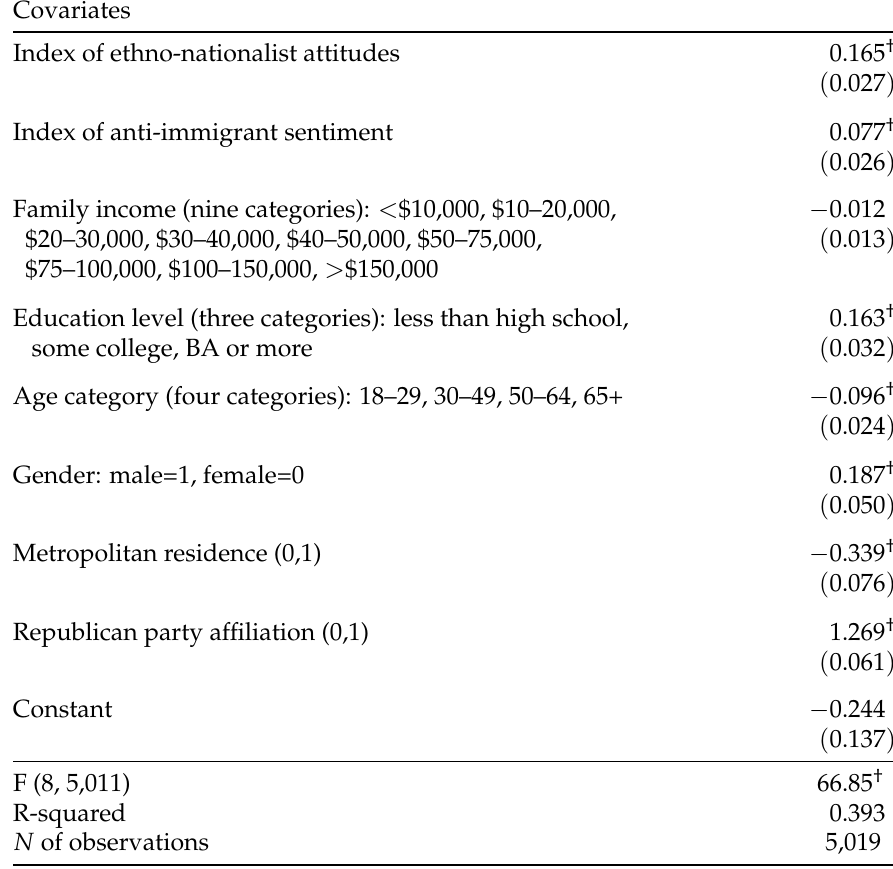
Table 2: Regression estimates of the effect of ethno-nationalist sentiment on